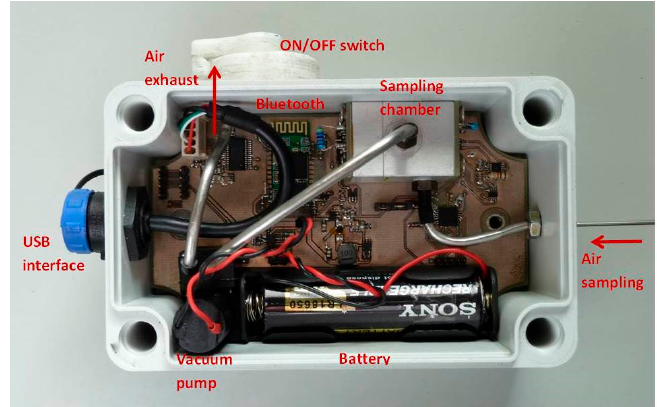
Figure 2. Prototype sensor device.